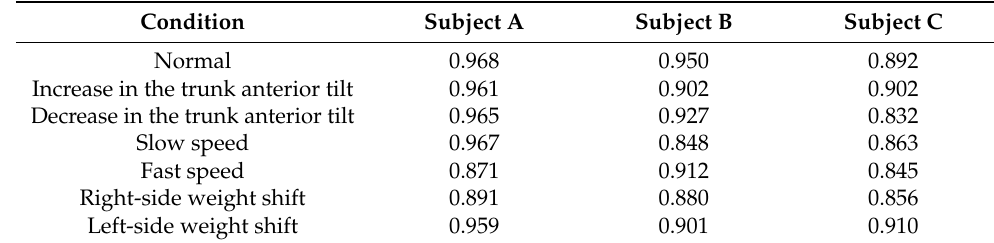
Table 1. Cross-correlation coefficients of the thigh angle during the sit-to-stand motion calculated using the chair with embedded laser range finders and the optical motion capture system.